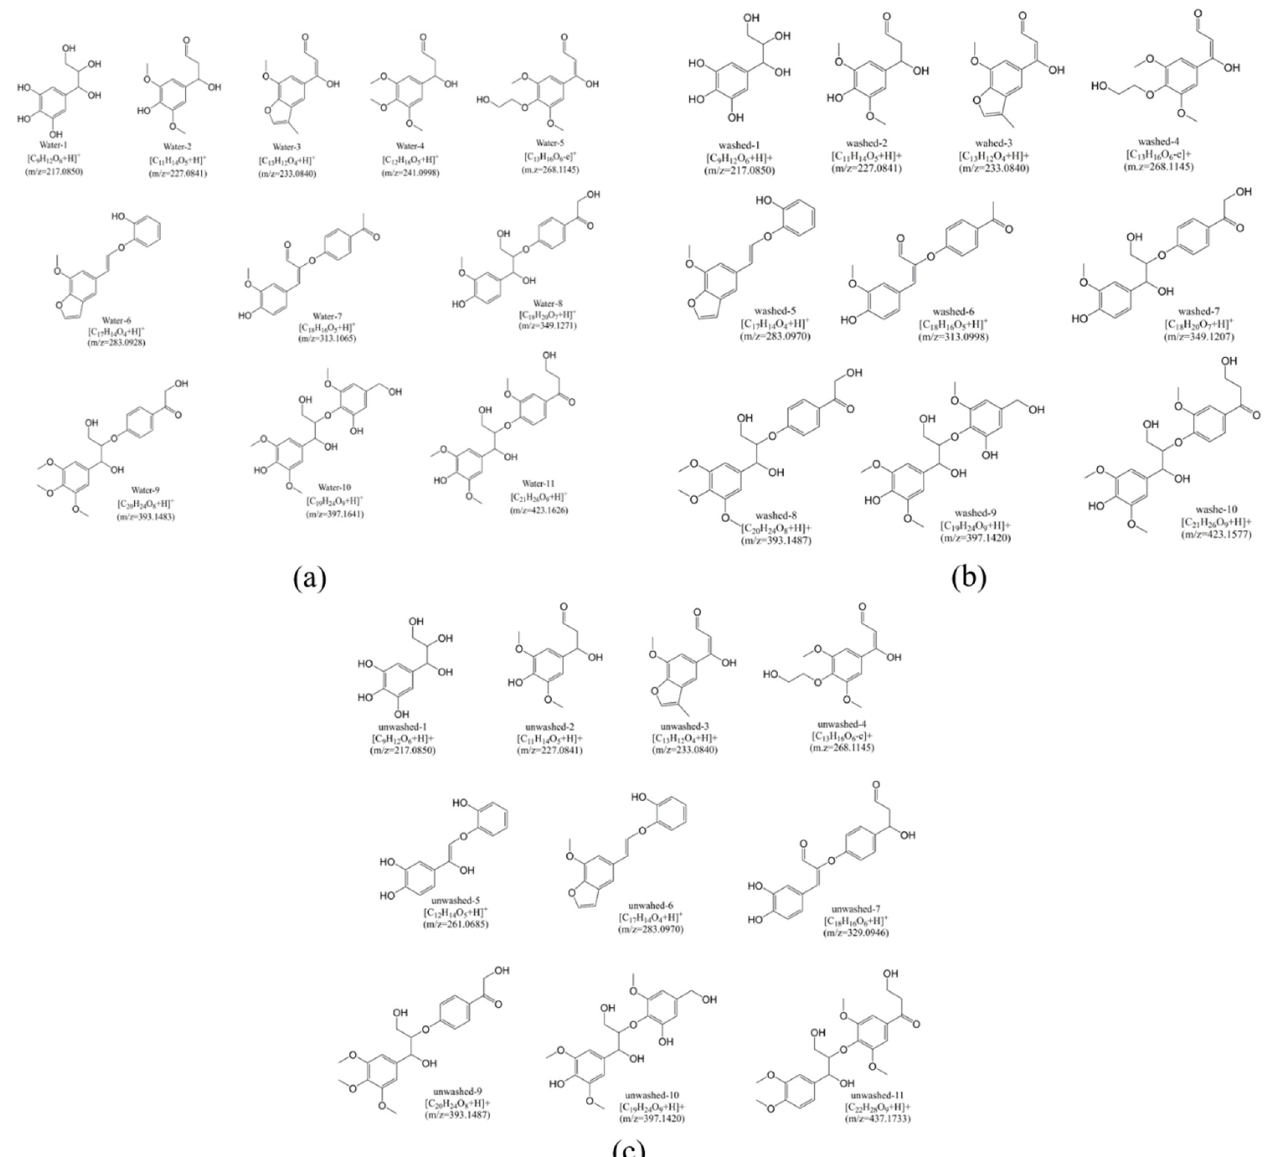
Figure 6. The structure of lignin-derived monomers and oligomers. ( a ) detected in “Water”; ( b ) detected in “Ni-washed”; ( c ) detected in “Ni-unwashed”.